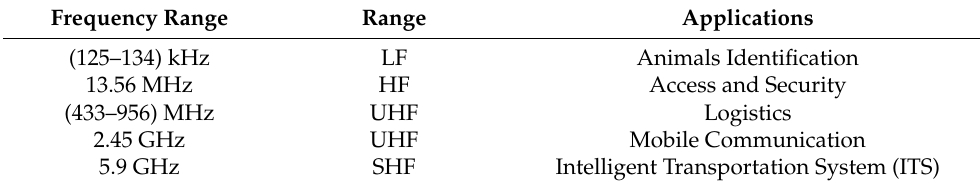
Table 1. Frequency Ranges and